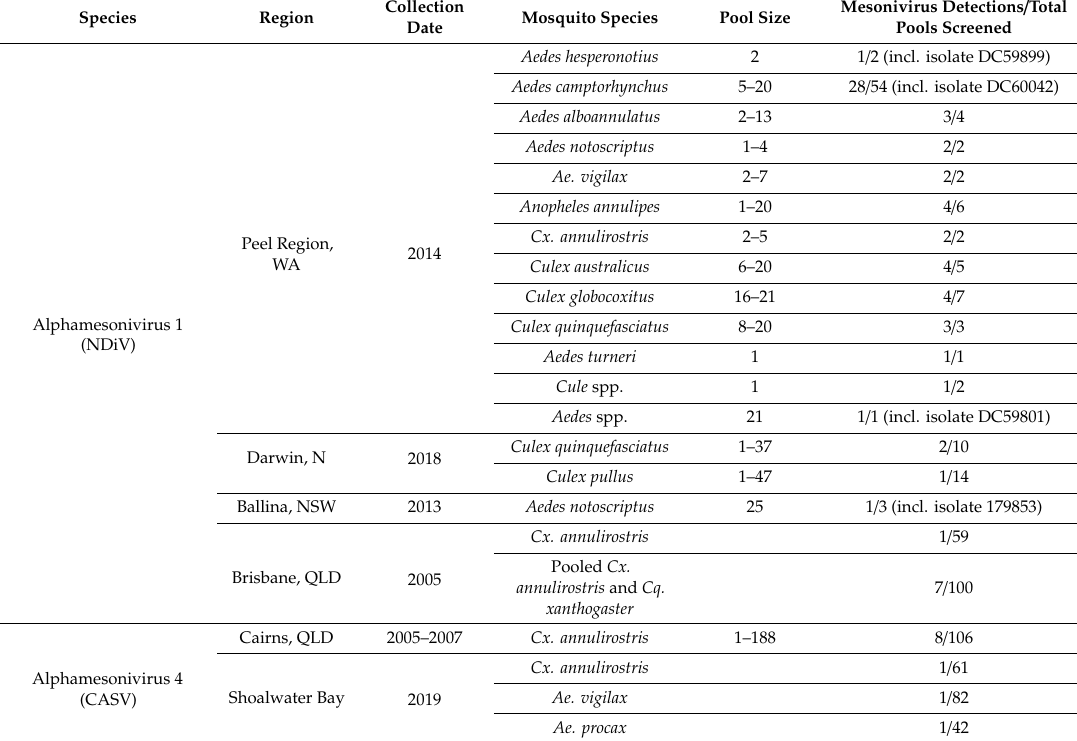
Table 1. Isolation of Casuarina virus (CASV) and Nam Dinh virus (NDiV) from mosquito species collected in